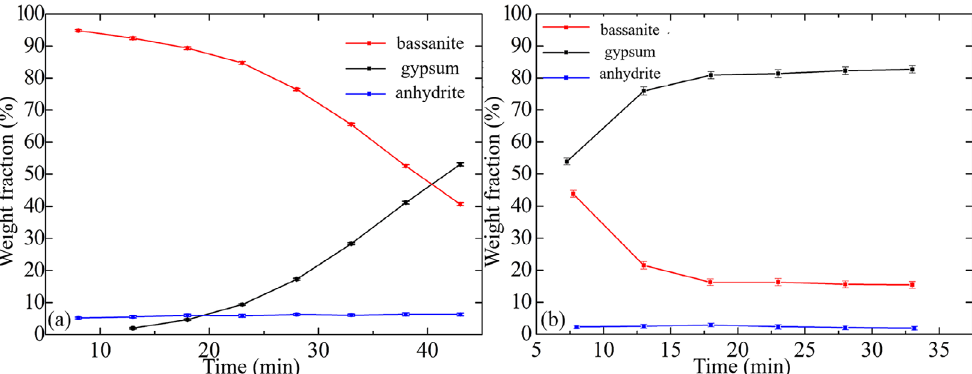
Figure 13. Mass fractions of the sulfate-based compounds (anhydrite - blue dots, bassanite - red dots, and gypsum - black dots) as a function of the hydration time of the samples (a) CP2 and (b) RP2 obtained by the sequential Rietveld